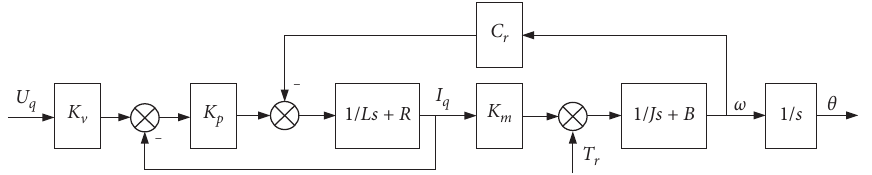
Figure 8: Load system structure diagram.